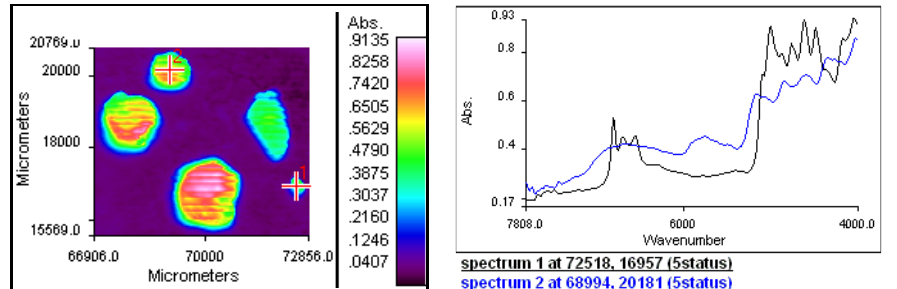
Fig. 2. The average absorbance imaging of sample